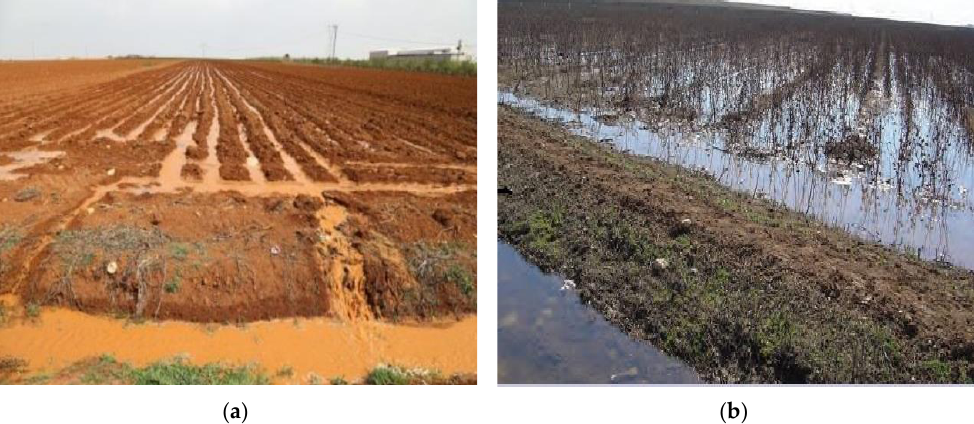
Figure 3. ( a ) Excessive surface irrigation in Harran Plain [21]; ( b ) Water ponding due to limited natural drainage in Harran Plain [22].